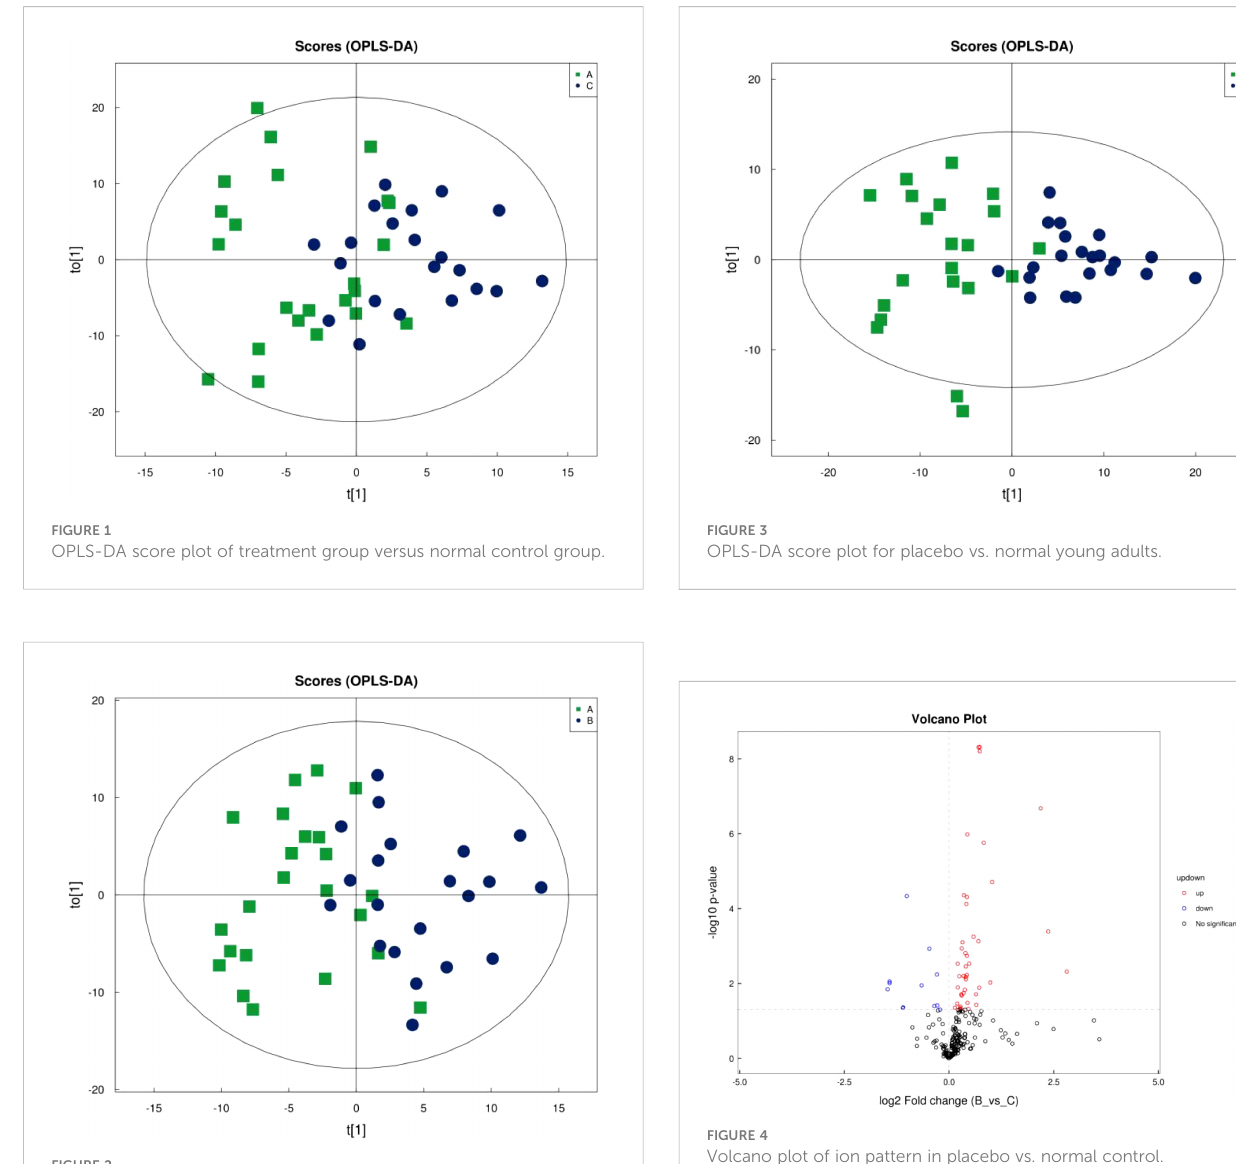
FIGURE 2 OPLS-DA Score Plot for Treatment Group versus Placebo Group.